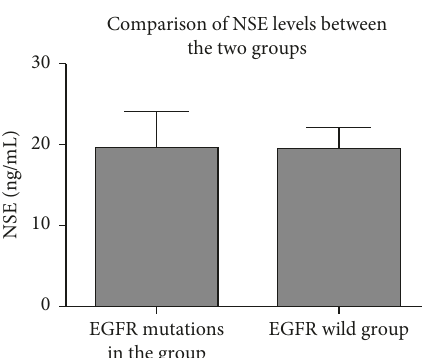
Figure 2: Comparison of NSE levels of two groups.